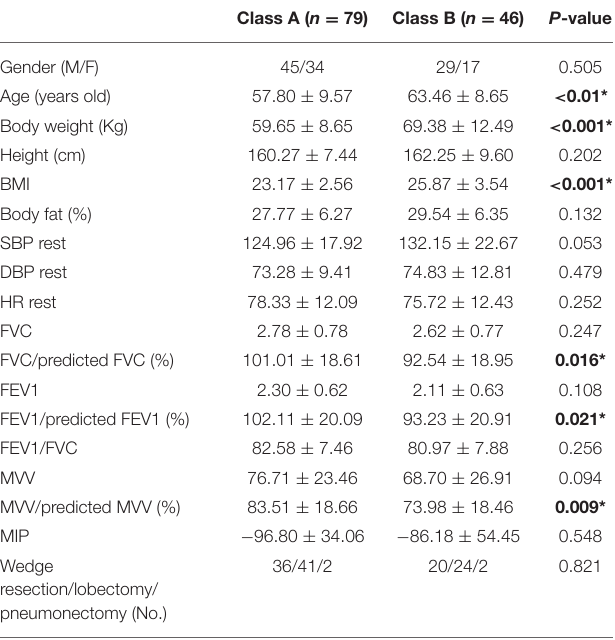
TABLE 2B | Baseline characteristics of each group defined by oxygen consumption at anaerobic threshold (VO 2 at